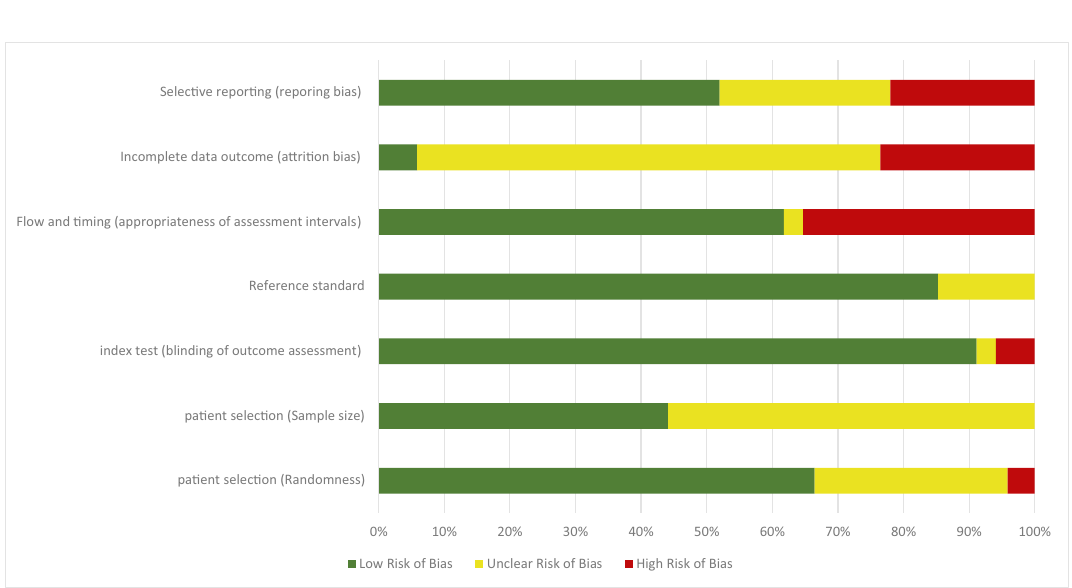
Figure 7. Risk of bias